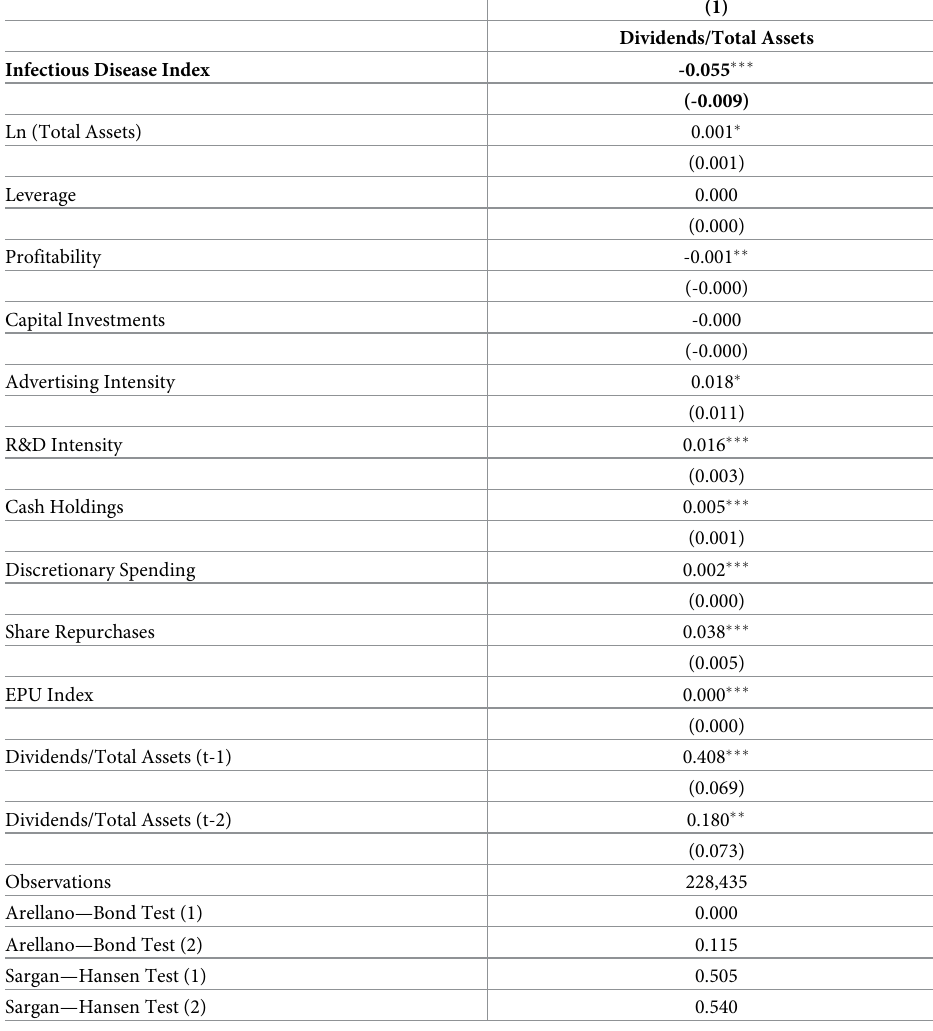
Table 7. Dynamic panel and overidentification restriction analysis. The set of instruments used in the difference equation are as follows: 1) contemporaneous values of Ln (Total Assets), Leverage, Profitability, R&D Intensity, Discre- tionary Spending, EPU Index, and the infectious disease equity market volatility as well as 2) contemporaneous and the first lag values of Capital Investments, Share Repurchases, Advertising Intensity, and Cash Holdings. We also included the second lag of Dividends/Total Assets as instruments in the difference equation as well. In total, there are 16 instruments.